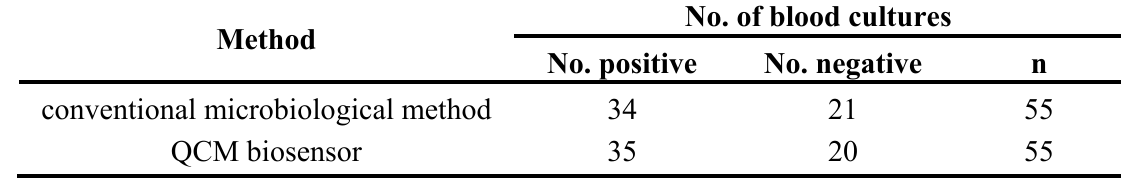
Table 2. Comparison of conventional microbiological method and QCM biosensor for detection of S. epidermidis